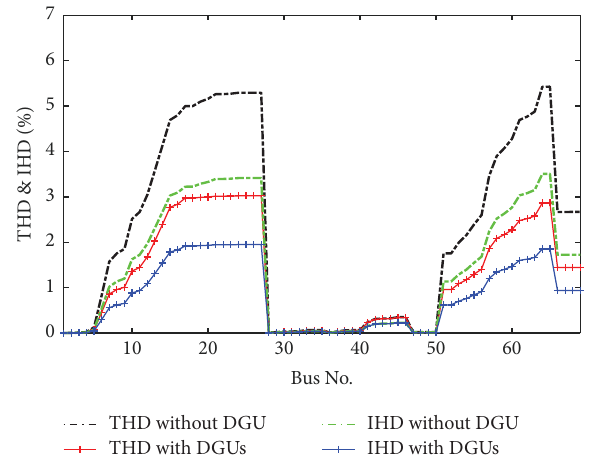
Figure 14: THD (%) and IHD (%) of the IEEE 69-bus system before and after DGUs